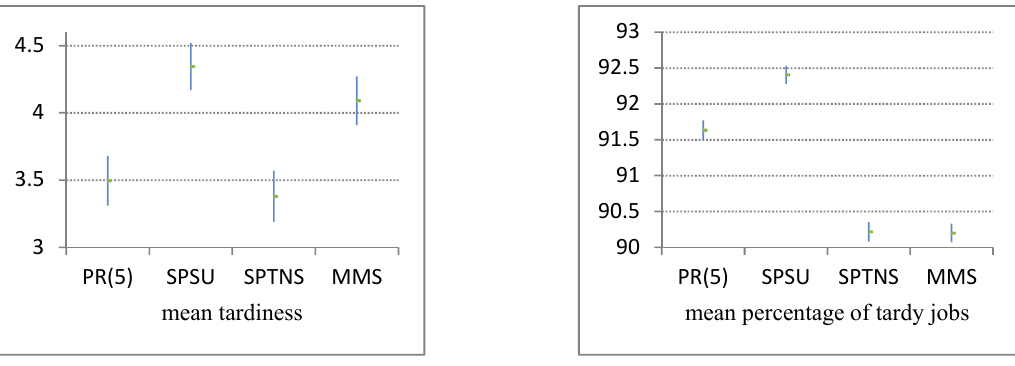
Fig. 13. Results from multiple comparison follow-up tests for mean tardiness and mean percentage of tardy jobs (three machine